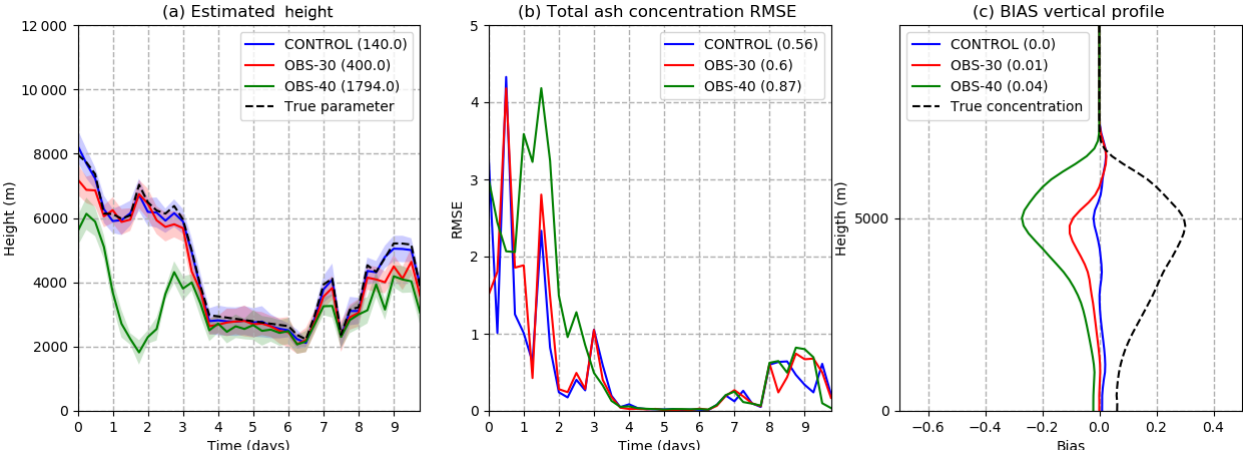
Figure 13. As in Fig. 11 but for the experiments CONTROL, OBS-30, and